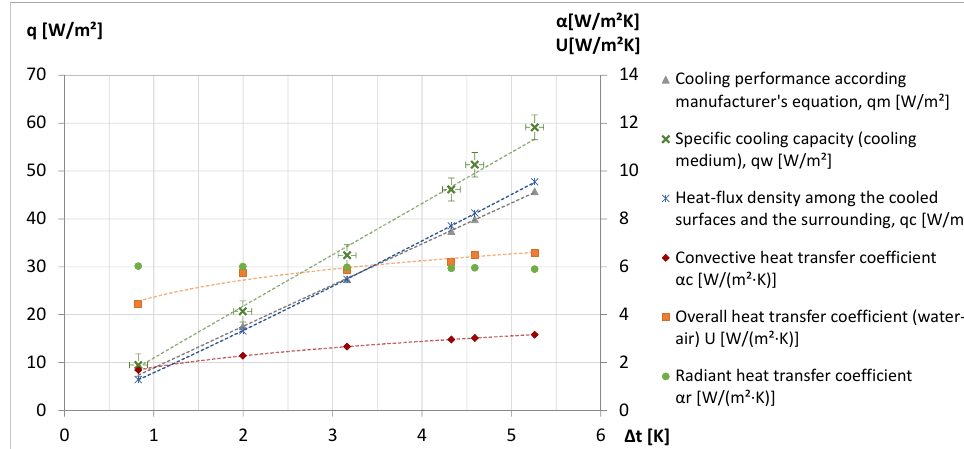
Figure 5. Experimental results for thermally activated ceiling—cooling mode.